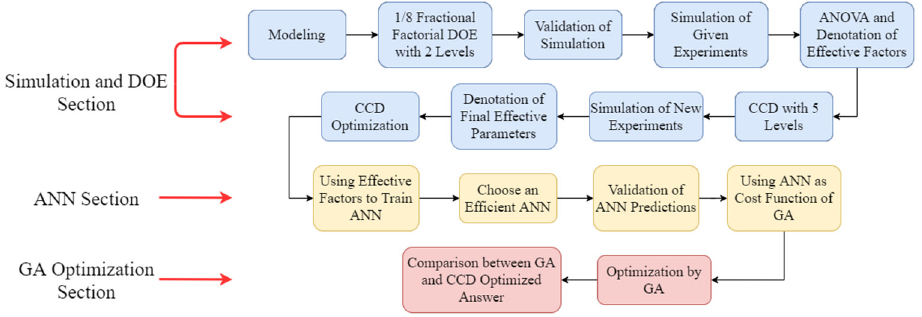
Figure 6. Flowchart of the research method.